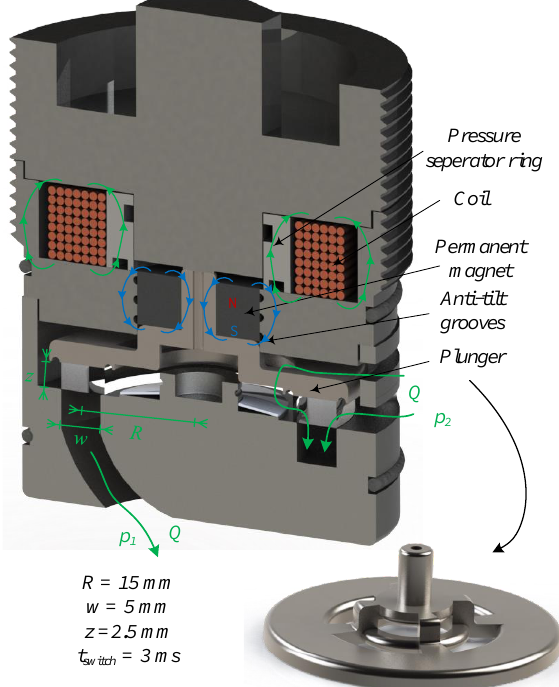
Figure 1: Cropped view of the digital valve switched by conducting a current in the coil (gives rise to the magnetic field marked by green